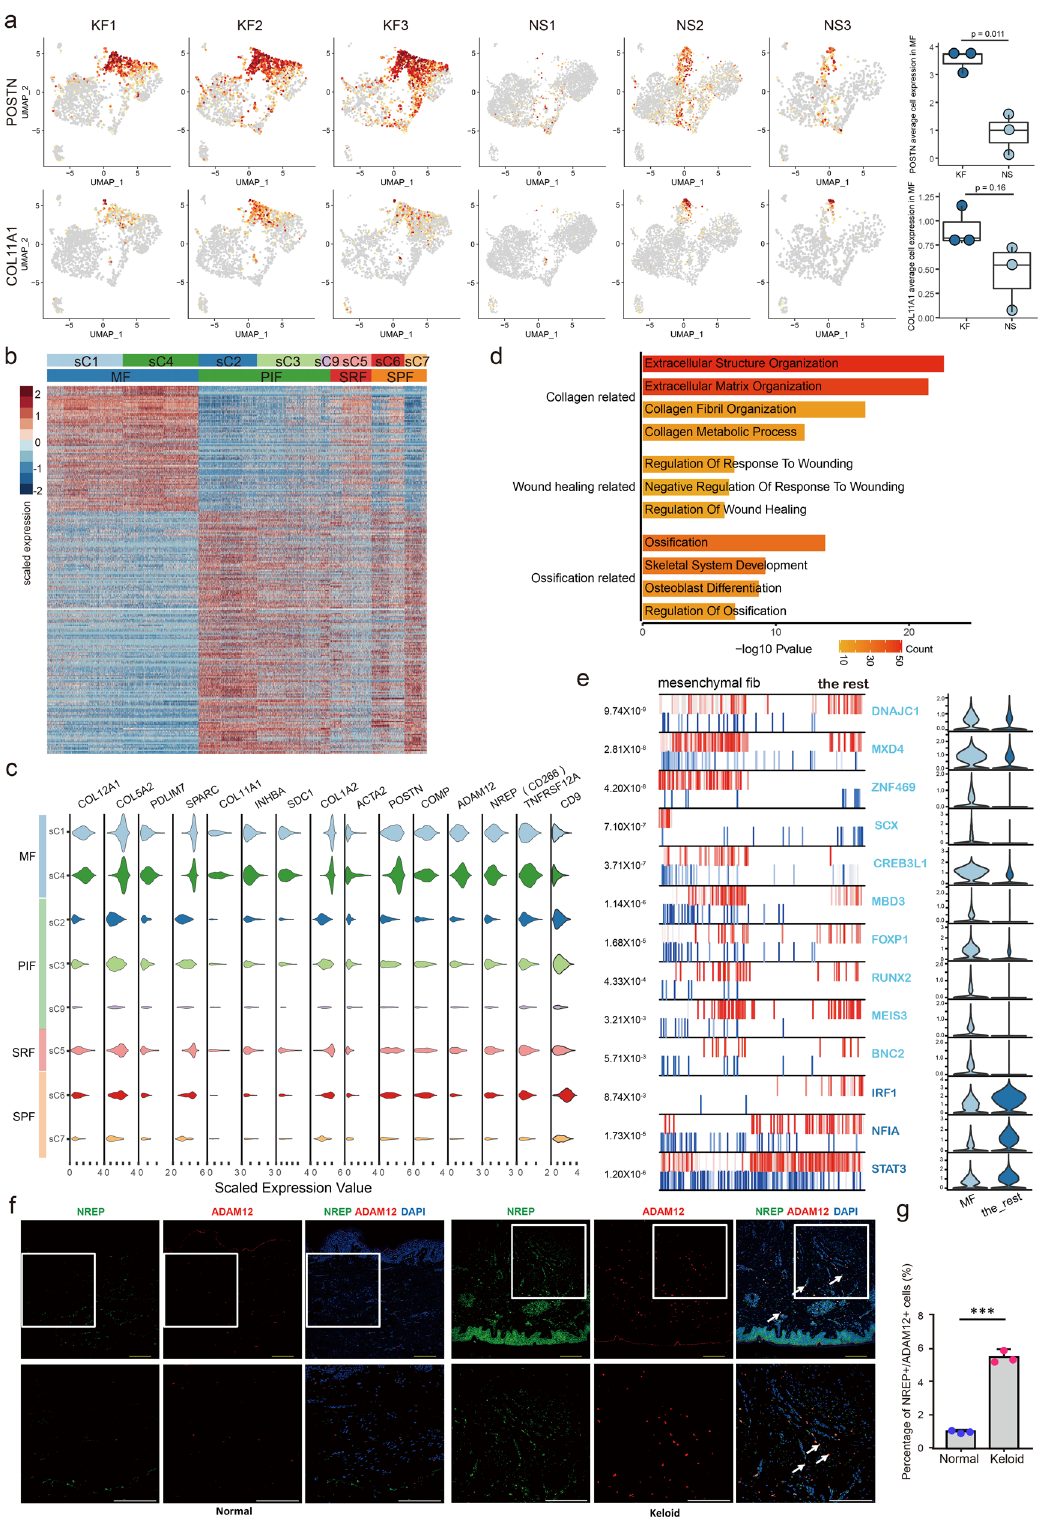
Mesenchymal fi broblasts are increased in scleroderma . To examine the consistency of our fi ndings in other fi brotic skin diseases, we investigated scRNA-seq data from a recent scler- oderma research 34 . We compared fi broblast data of scleroderma with our No. 3 normal scar fi broblast data because they had similar fi broblasts numbers. We performed unsupervised clus- tering on all scleroderma and normal scar fi broblasts and